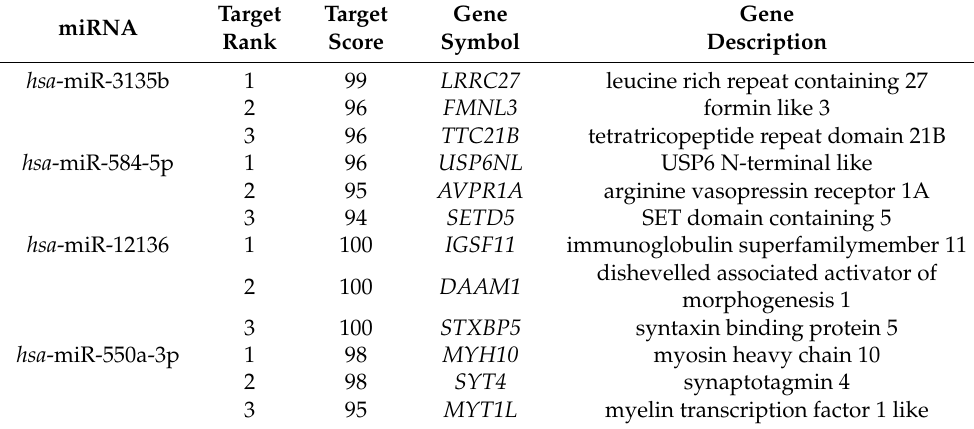
Table 3. miRNA target prediction using miRDB. Top 3 predictions for each differentially expressed miRNA ( hsa -miR-3135b, hsa -miR-584-5p, hsa -miR-12136, and hsa -miR-550a-3p). hsa -miR-3135b targets LRRC27 , FMNL3 , and TTC21B ; hsa -miR-584-5p targets USP6NL , AVPR1A and SETD5 ; hsa